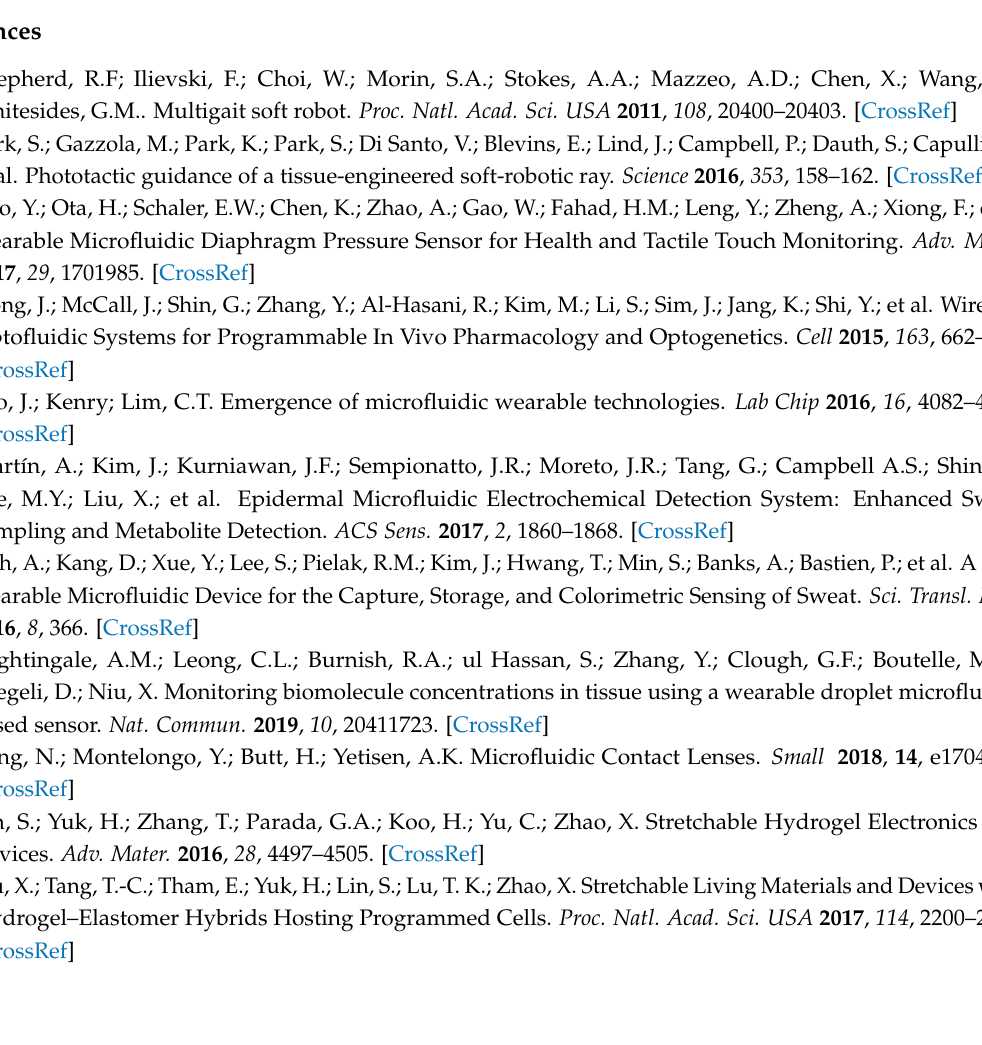
s1, Table S1: Design dimension of the molds and the corresponding fabricated PEGDA waveguide radii ( n = 2), Figure S1: ( a ) Waveguiding using PEGDA 700, 90 % ( n = 1.462) as core with a radius of 400 µ m cladded with PEGDA 700, 40%. ( b ) Photo taken from the lateral side of the PEGDA waveguide. The fabricated waveguides can still guide light even more than 2 months after fabrication. Figure S2: Fabricated straight waveguide (length = 10 cm) with PDMS as the cladding and PEGDA 700, 90 % as the core (radius = 500 µ m). Waveguide is extremely flexible as seen in the series of images showing that a significant light output is still present even with increasing waveguide bending. Scale bar is 5 cm. Figure S3: Stability measurements of the fabricated waveguides. ( a ) Output power from the straight waveguide over time for 300 µ m, 400 µ m, 500 µ m waveguide radius. Note that power readings are stable for 30 min. ( b ) Rhodamine fluorescence emission from the microfluidic chip with integrated PEGDA waveguides. The emission intensity is very stable for 25 min. Data presented here are an average of three